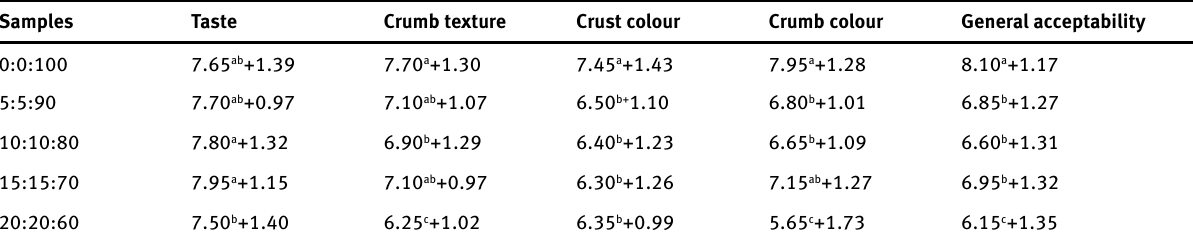
Table 4: Sensory evaluation scores of the bread samples Samples Taste Crumb texture Crust colour Crumb colour General